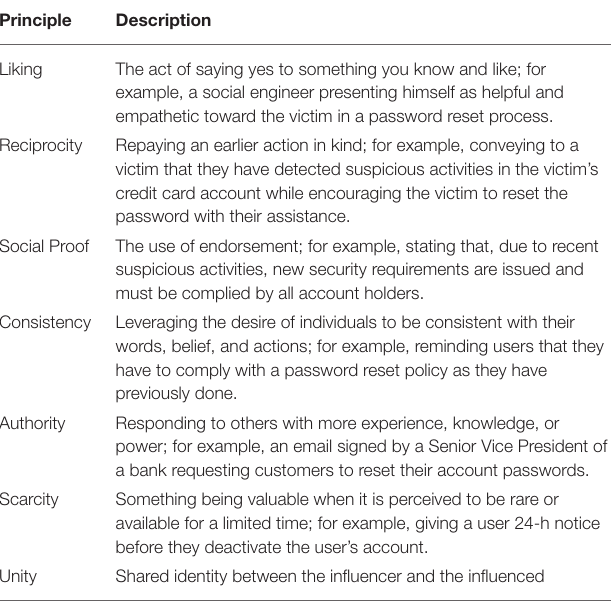
TABLE 1 | Summary of Cialdini Principles of Persuasion. Principle Description